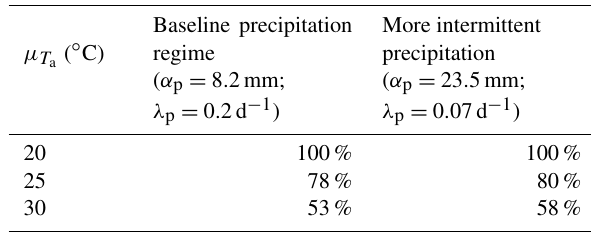
Table 1. Reduction in the potential for heat stress by irrigation, as summarized by the median reductions in P CHS from rainfed crop- ping to stress avoidance irrigation, using rainfed as